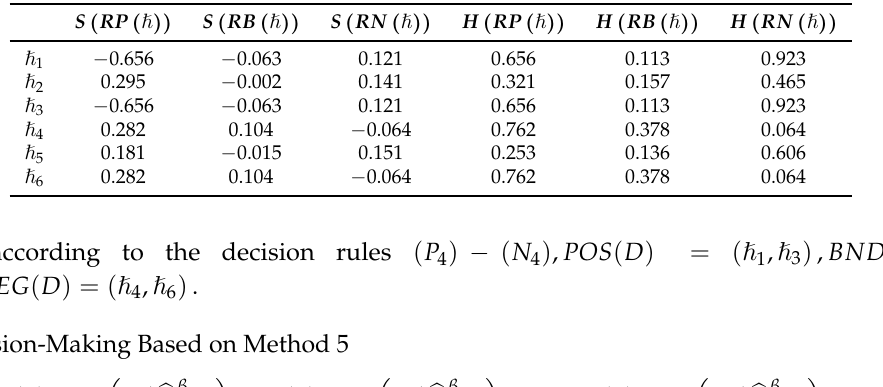
Table 8. The score and accuracy functions of expected losses in this Example.